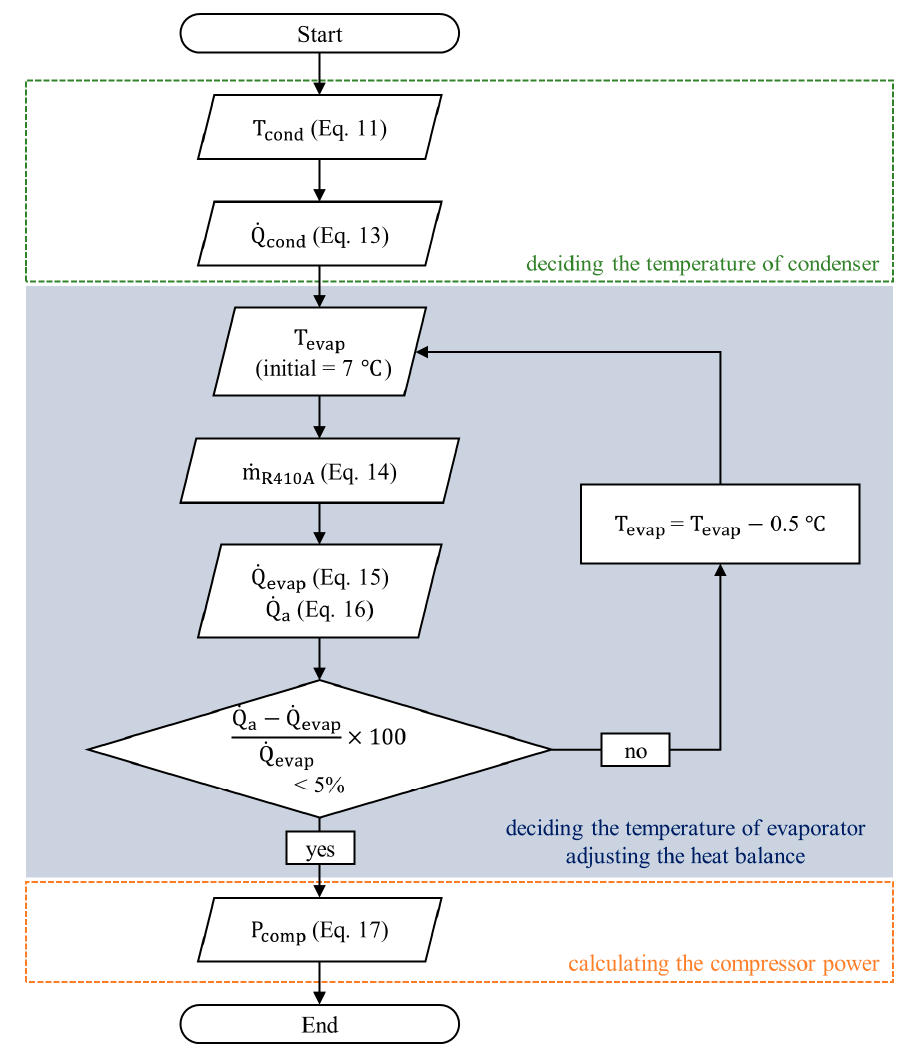
Figure 9. Calculation process flowchart in the heat pump.